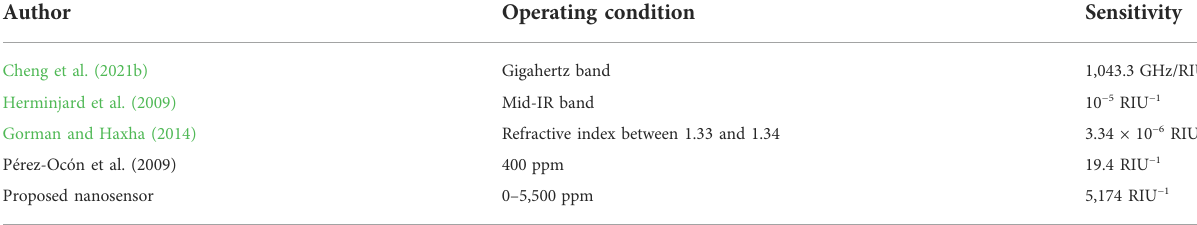
TABLE 7 Comparison between the proposed sensor and some related CO 2 sensors used in the refractive index